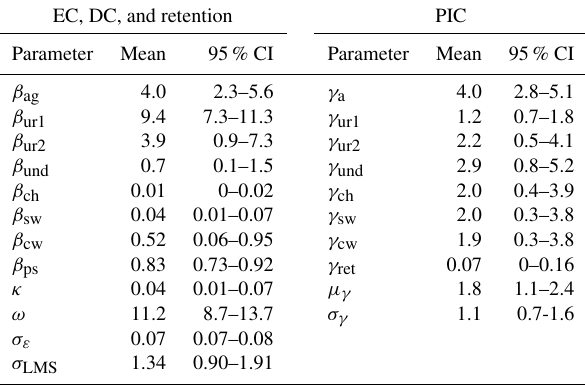
Table 3. Mean posterior parameter estimates for export and delivery coefficients ( β ; EC, DC), retention rates ( κ , ω ), and precipitation impact coefficients ( γ ; PIC) along with 95% credible intervals (CI). Note that subscripts are same as defined in Eq.